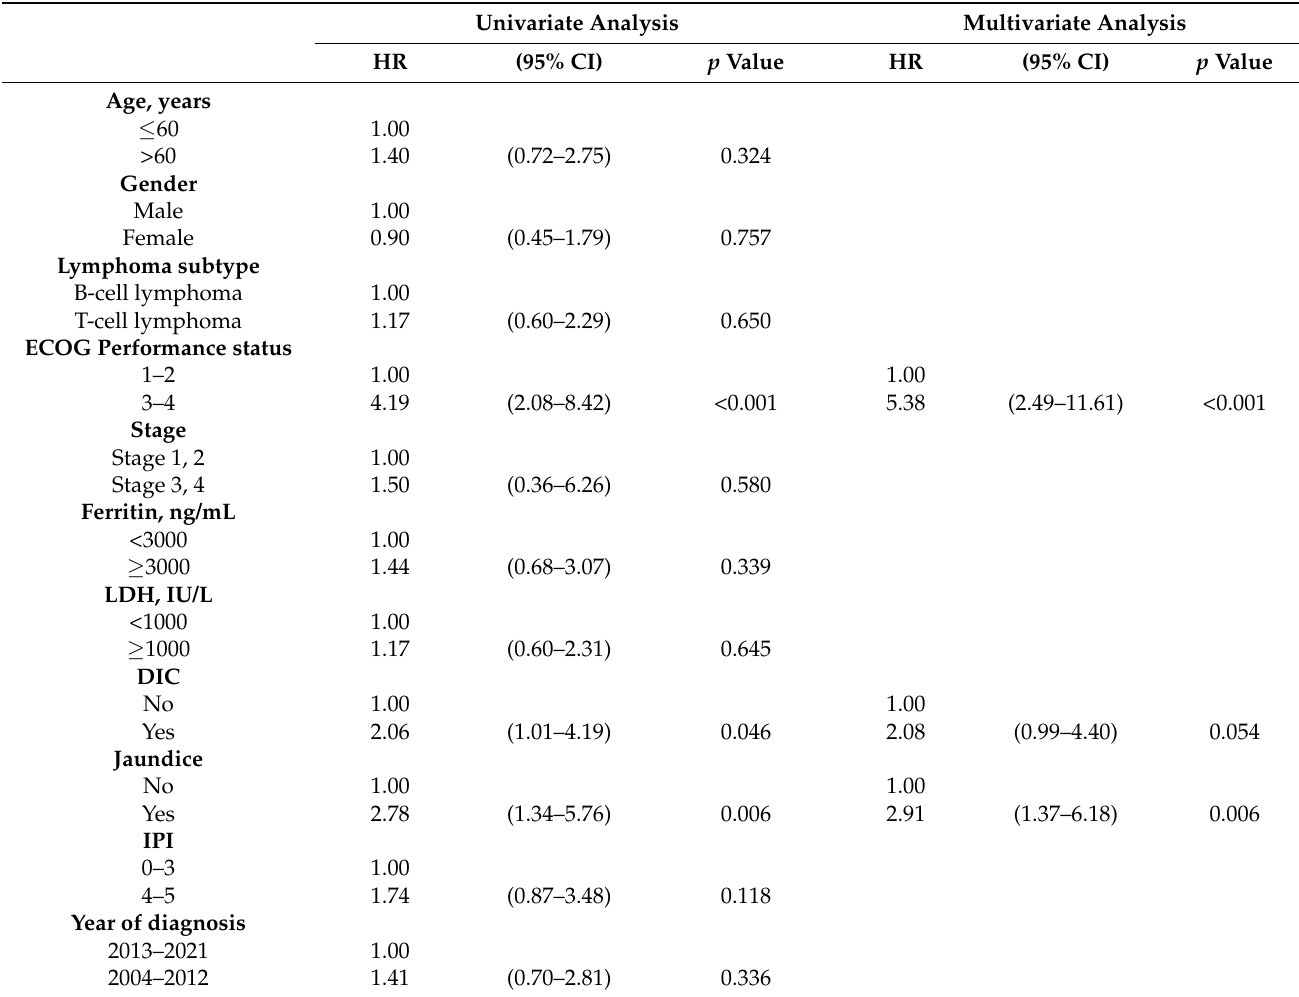
Table 4. Prognostic factors of lymphoma-associated HLH. Univariate Analysis Multivariate